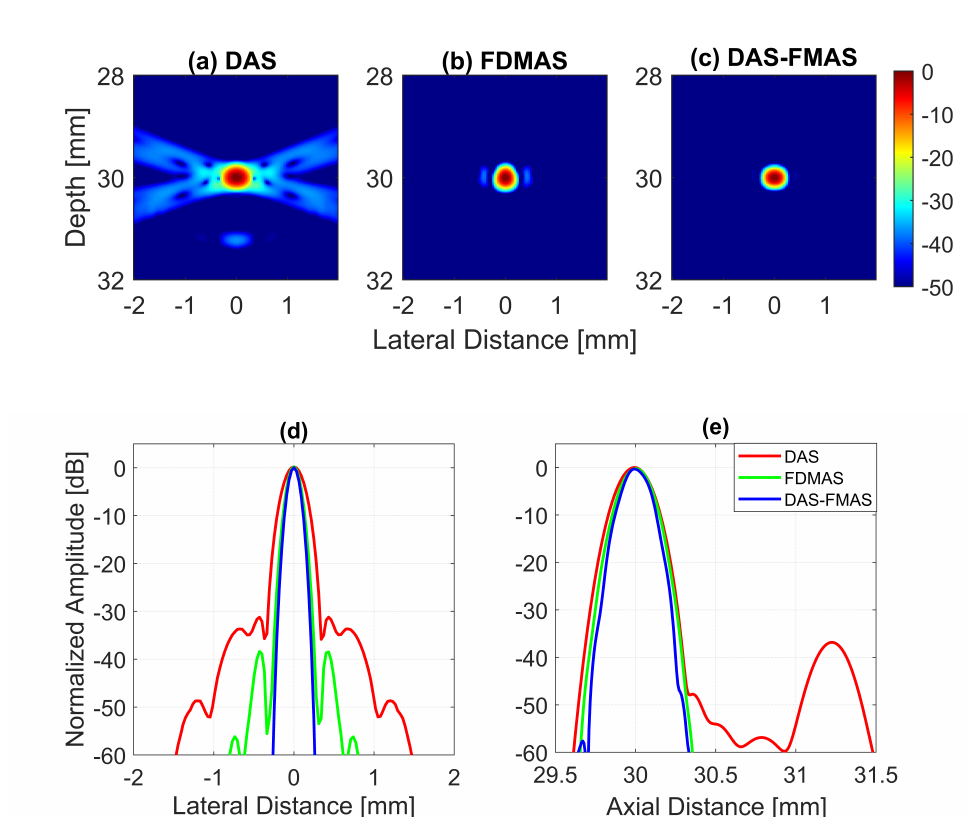
Figure 8. Single-point target compound PWI B-mode images beamformed with ( a ) DAS, ( b ) FDMAS and ( c ) DAS-FMAS, N = 3 ( − 12 ◦ , 0 ◦ , + 12 ◦ ). The lateral beam profile at a depth of 30 mm and the axial beam profile at x = 0 mm are shown in ( d , e ) for all three beamforming techniques (DAS, FDMAS and